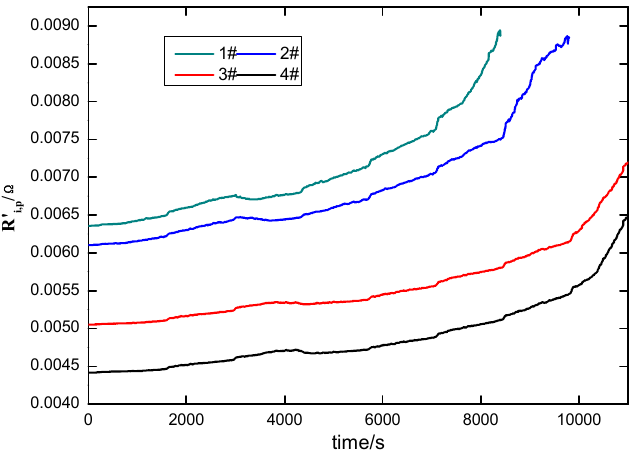
Figure 11. PCBG resistance vs. cell resistance increase fault.